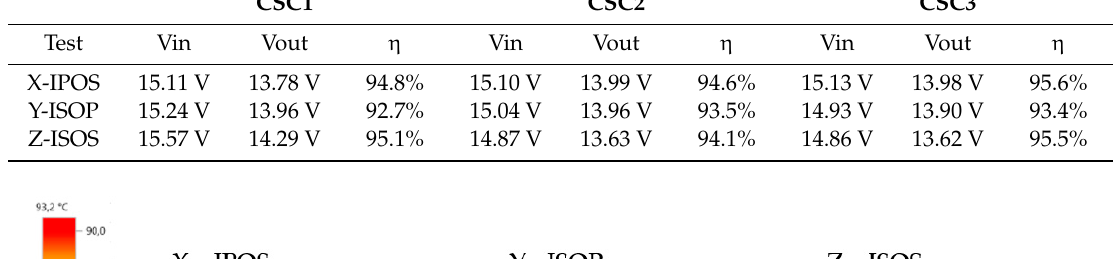
Table 6. Measures at CSC level of various PCA configurations with the same CAA arrangement.